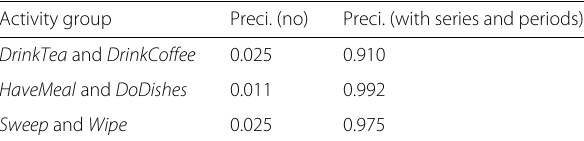
Table 5 The inference probability of the two similar interleaved activities